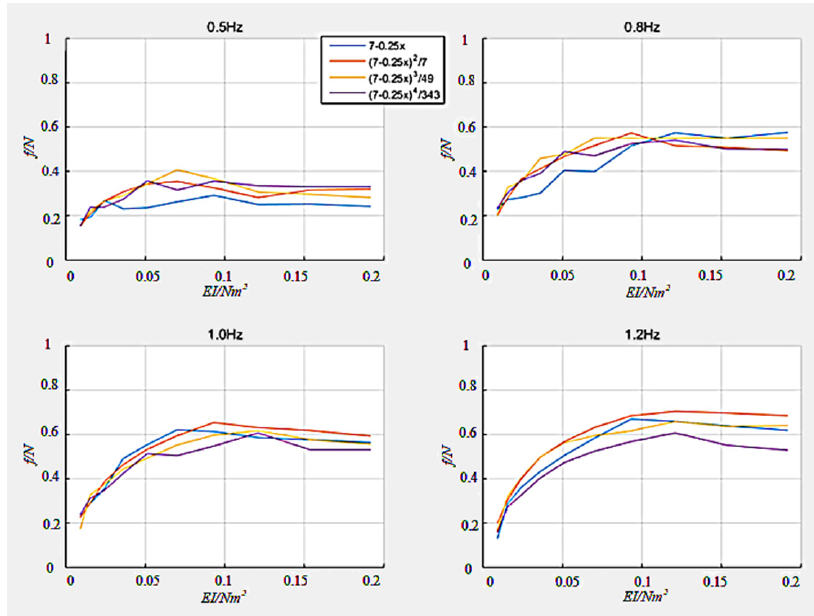
Figure 8. Thrust—bending stiffness diagrams of fish tails with four different rates of change curves under different stiffnesses and frequencies.